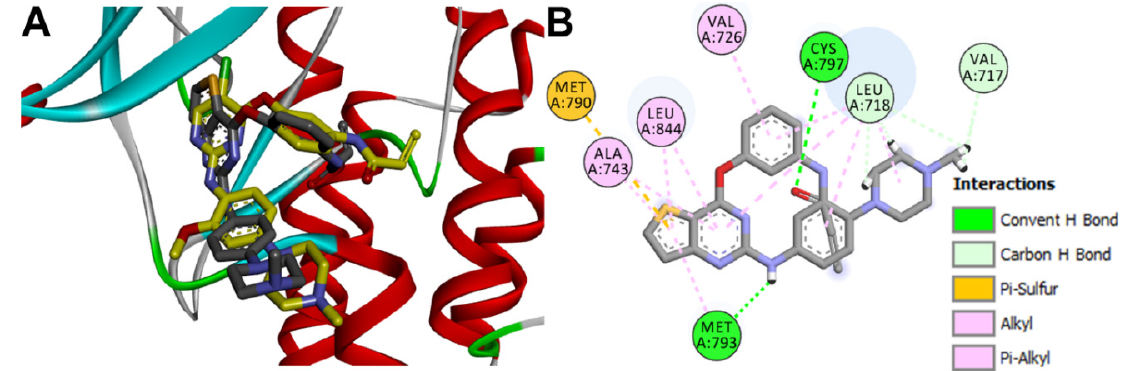
Figure 17. Binding mode/interactions of olmutinib (shown as sticks colored by element) into EGFR 696-1022 T790M (pdb: 5X2K): ( A ) 3D binding mode of olmutinib overlaid with the co-crystallized ligand, WZ4003 (yellow sticks); ( B ) 2D binding mode of olmutinib showing different types of binding interactions.